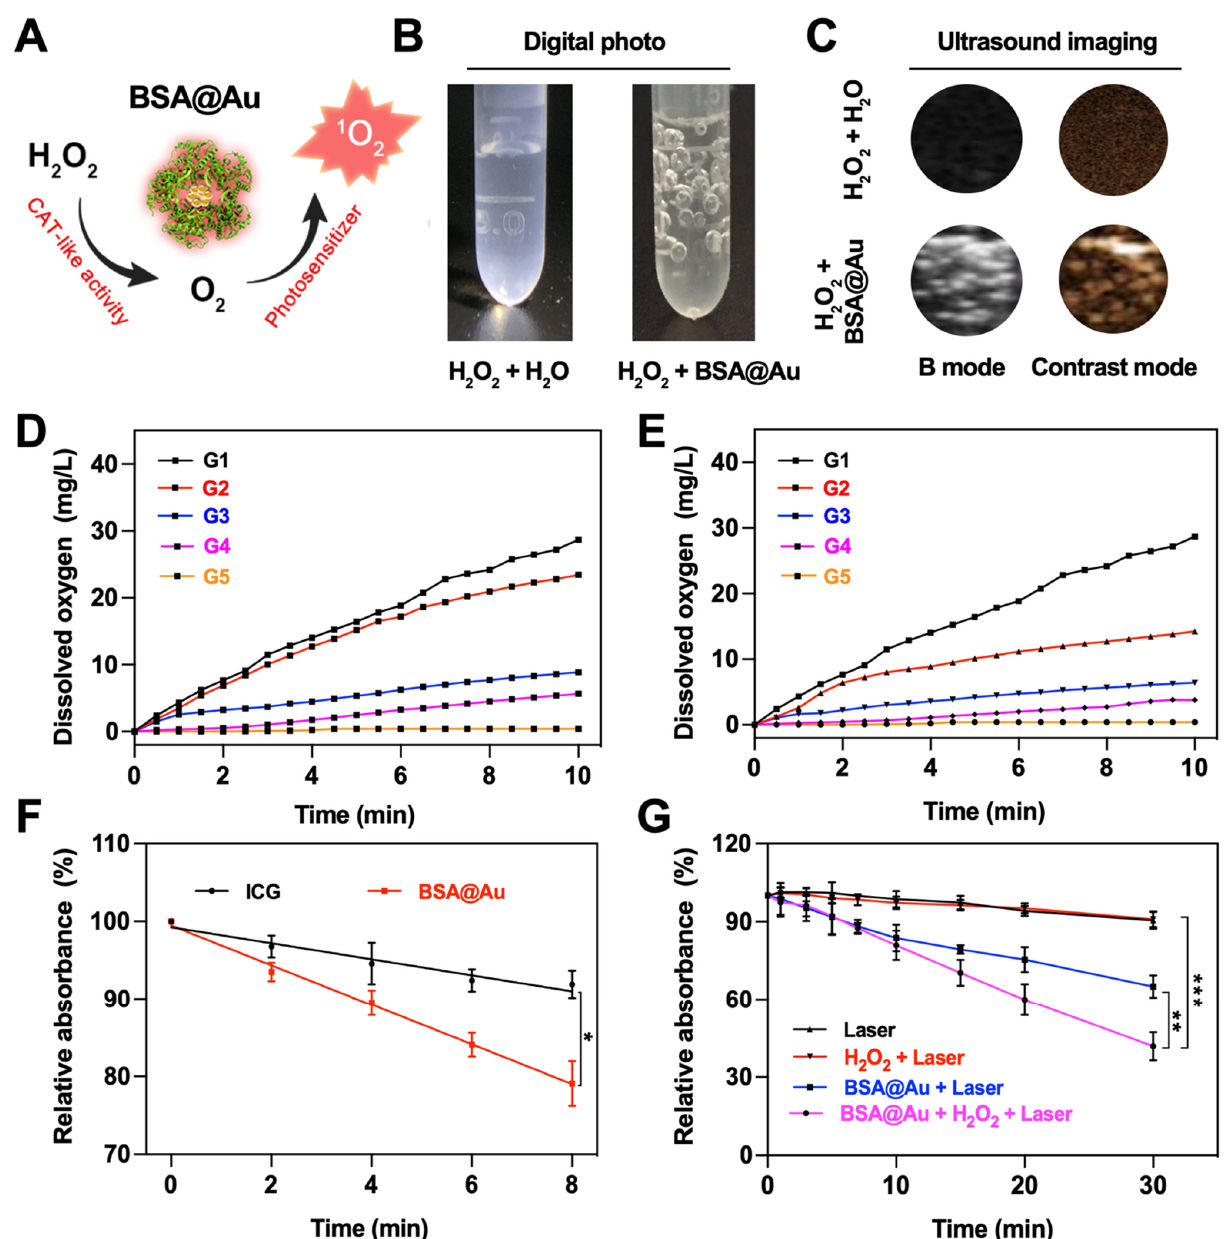
Figure 2. Catalase (CAT)-like activity and 1 O 2 generation ability of BSA@Au. ( A ) Scheme of BSA@Au worked as a catalase mimic and photosensitizer in cascade reactions. ( B ) Photograph of bubbles generated from reaction between BSA@Au and H 2 O 2 . ( C ) Bubbles generation imaged by ultrasound device on B mode and contrast mode. ( D ) O 2 production from H 2 O 2 of different concentrations decomposed by BSA@Au. G1: H 2 O 2 (12.5 mM) + BSA@Au (0.23 mM); G2: H 2 O 2 (9.37 mM) + BSA@Au (0.23 mM); G3: H 2 O 2 (6.25 mM) + BSA@Au (0.23 mM); G4: H 2 O 2 (1.25 mM) + BSA@Au (0.23 mM); G5: H 2 O 2 (12.5 mM) + H 2 O. ( E ) O 2 production from H 2 O 2 catalyzed by BSA@Au of various concentrations. G1: H 2 O 2 (12.5 mM) + BSA@Au (0.23 mM); G2: H 2 O 2 (12.5 mM) + BSA@Au (0.12 mM); G3: H 2 O 2 (12.5 mM) + BSA@Au (0.06 mM); G4: H 2 O 2 (12.5 mM) + BSA@Au (0.03 mM); G5: H 2 O 2 (12.5 mM) + H 2 O. ( F ) 1 O 2 production efficiency of BSA@Au measured by DPBF in absorbance at 414 nm under 808 nm laser irradiation with ICG as a reference. ( G ) 1 O 2 generation measured by DPBF at 414 nm against time in the presence of different solutions. * p < 0.5, ** p < 0.01, *** p <